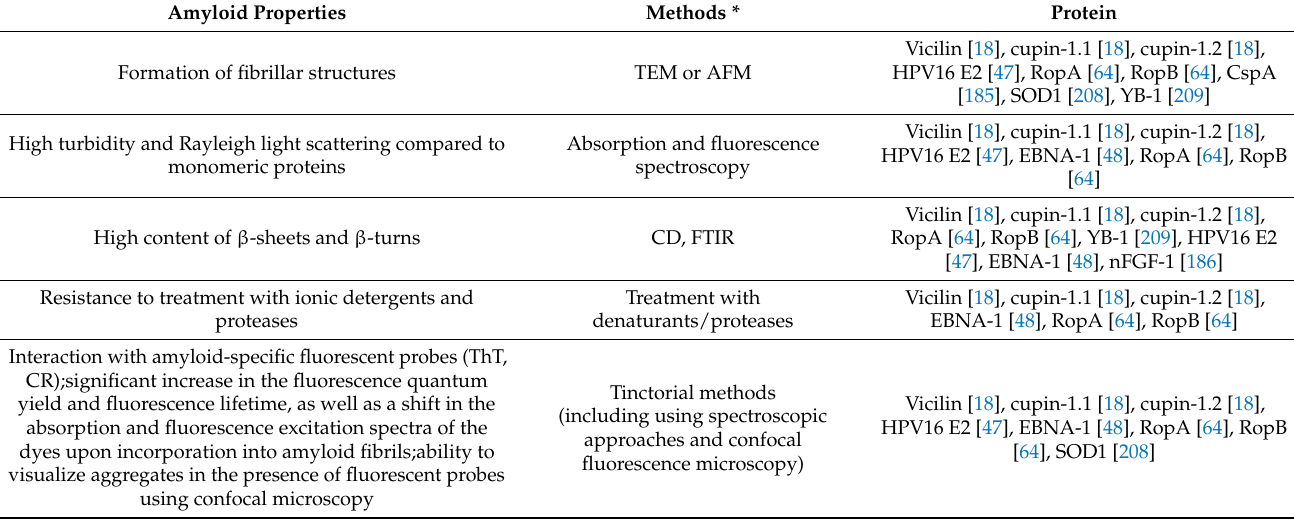
Table 1. Amyloid properties of β -barrel proteins discussed in this